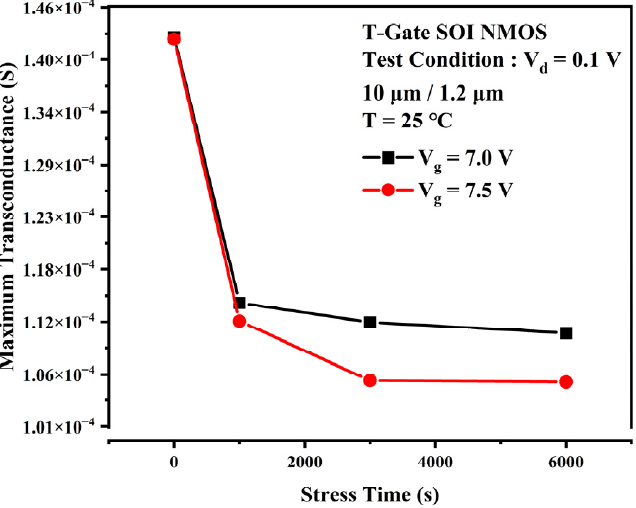
Figure 4. Degradation of transconductance of the device when the TDDB stress is applied: ( a ) Vg = 7 V, ( b ) Vg = 7.5 V.